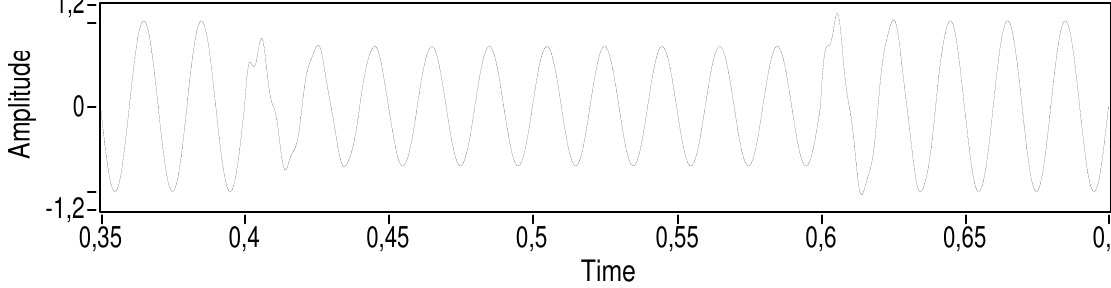
Figure 4. Sag with a coupled oscillatory transient. Time series of a sag with a depth of 30% and a duration of 10 cycles, with an oscillatory transient with a maximum amplitude of a 0.2, a duration of four cycles of the power signal and a frequency of 200 Hz.